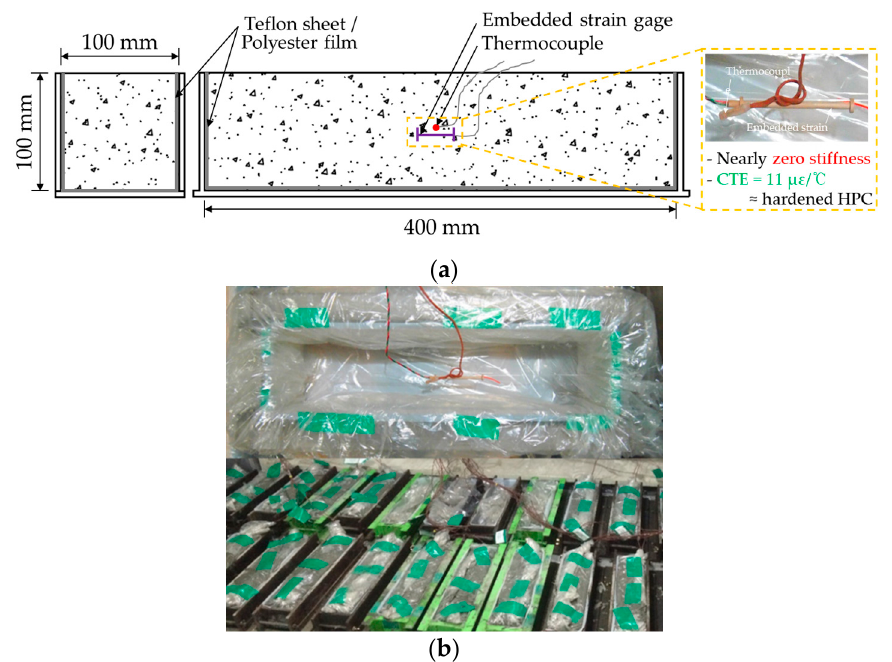
Figure 1. Shrinkage test under free condition: ( a ) conceptual figure of setup; ( b ) details of specimen after casting concrete.